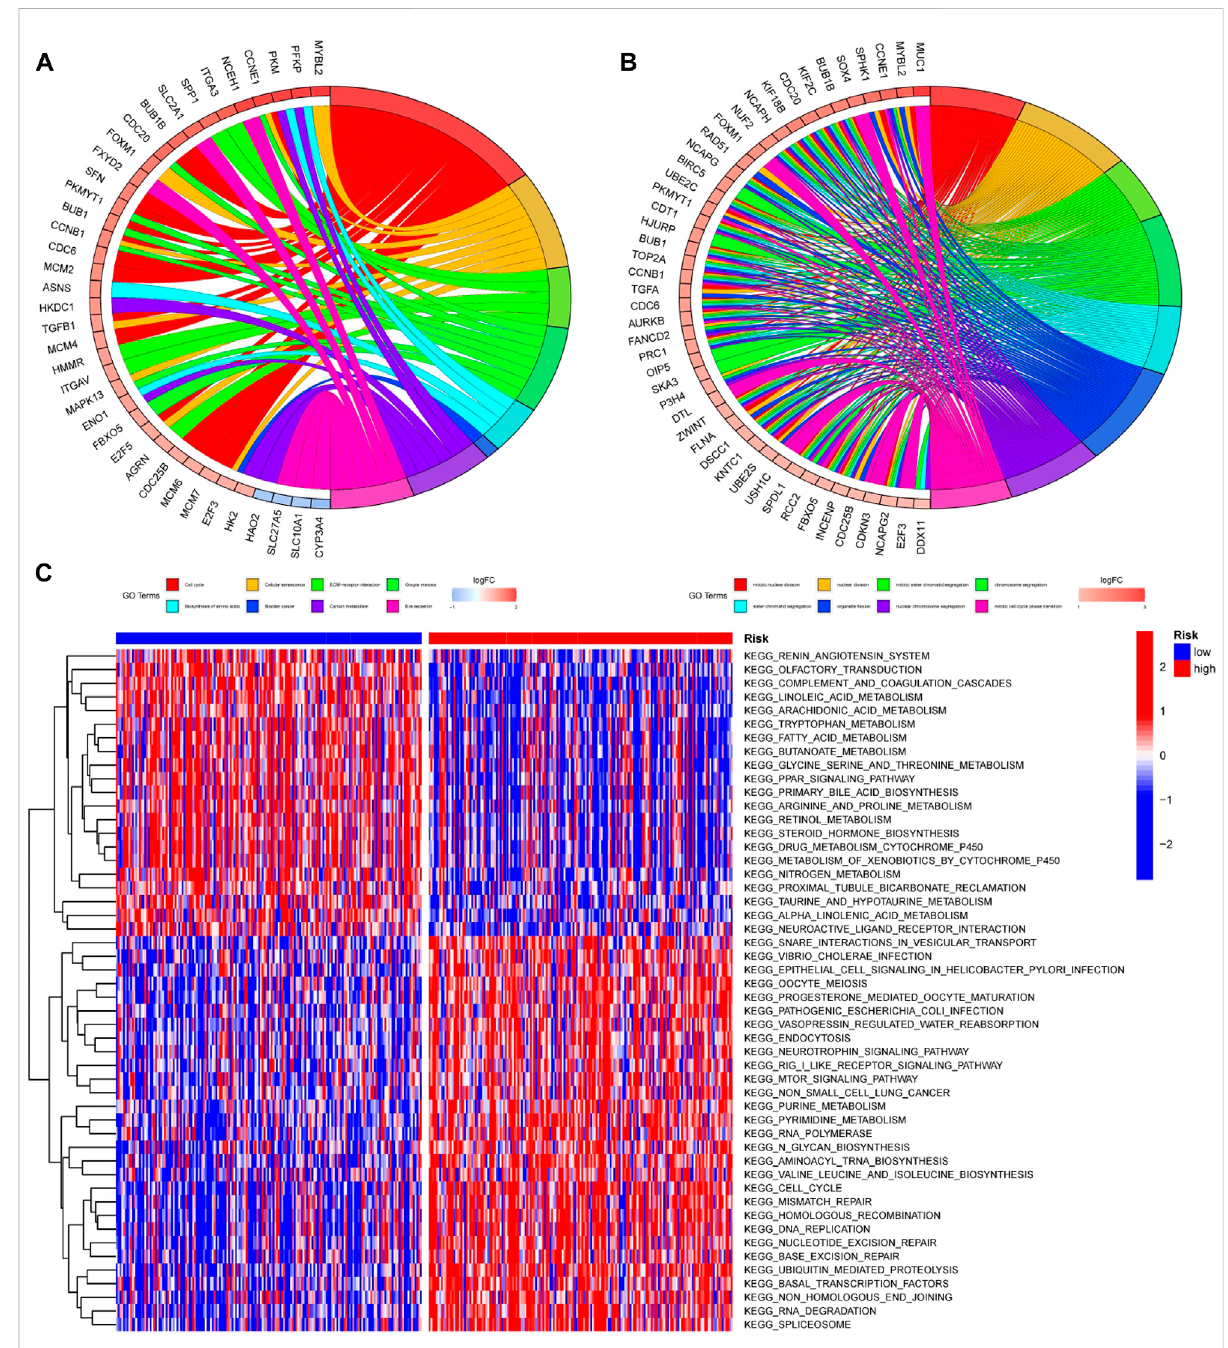
FIGURE 10 Enrichment analysis of DEGs among patients with different risk scores (A,B) GO and KEGG enrichment analysis was performed on genes differentiallyexpressedamongpatients indifferentrisk groups. The lefthalf ofthecircle diagram was thegene item, and theright was theannotated function item; ( C) GSVA analysis could analyze the pathways between patients with different risks, and the results were shown in the heatmap. Blue meant the pathway down, red meant the pathway up. The blue horizontal axis above the fi gure represented the low-risk group, and the red horizontal axis represented the high-risk